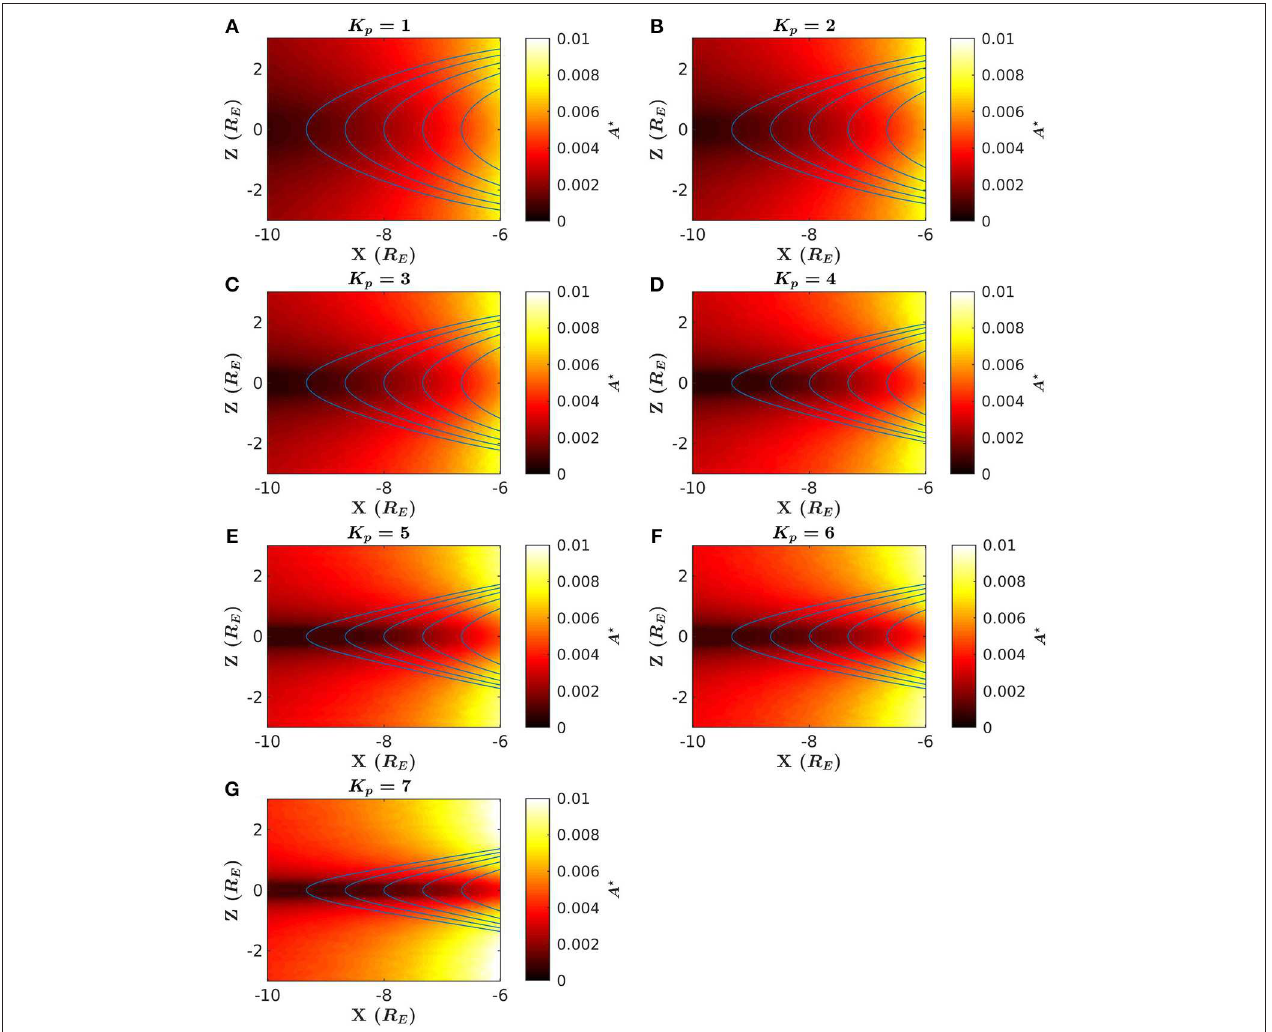
FIGURE 2 | A ⋆ plotted over midnight local time for various K p assuming a beam energy of 1 MeV: (A) K p (F) K p 6, (G) K p 7. Blue curves represent field-lines that intersect chosen values of X on the equatorial plane. Darker and lighter regions indicate regions with = = smaller and greater values of A ⋆ ,